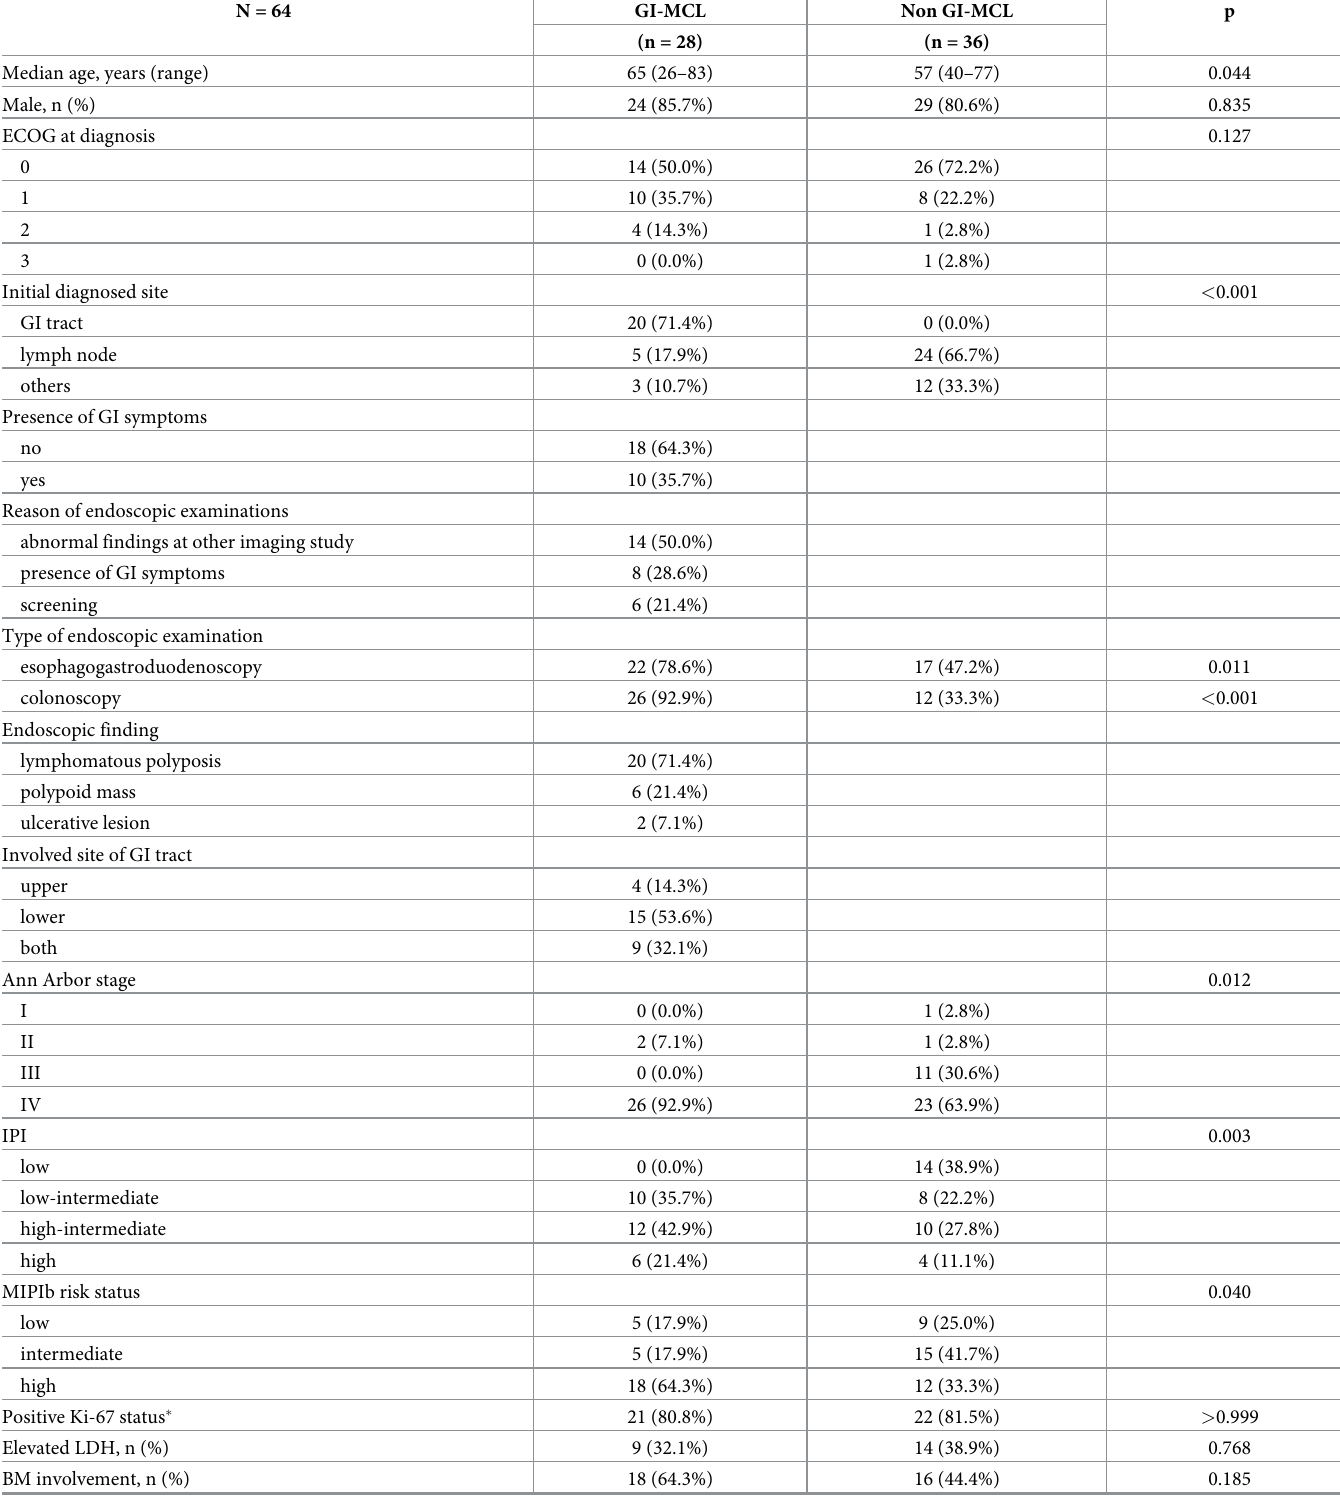
Table 1. Demographics and baseline characteristics of included patients according to gastrointestinal tract